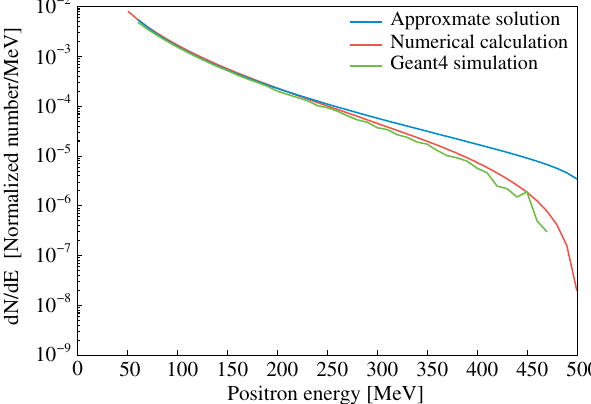
FIG. 1. Comparison of differential spectra obtained by differ- ent methods at three radiation lengths. The red curve was calculated by Eq. (8), the blue curve was obtained by a numerical method, and the green curve was simulated by Geant4. The energy of the incident electron is 500 MeV and the transmission length is 3 RL